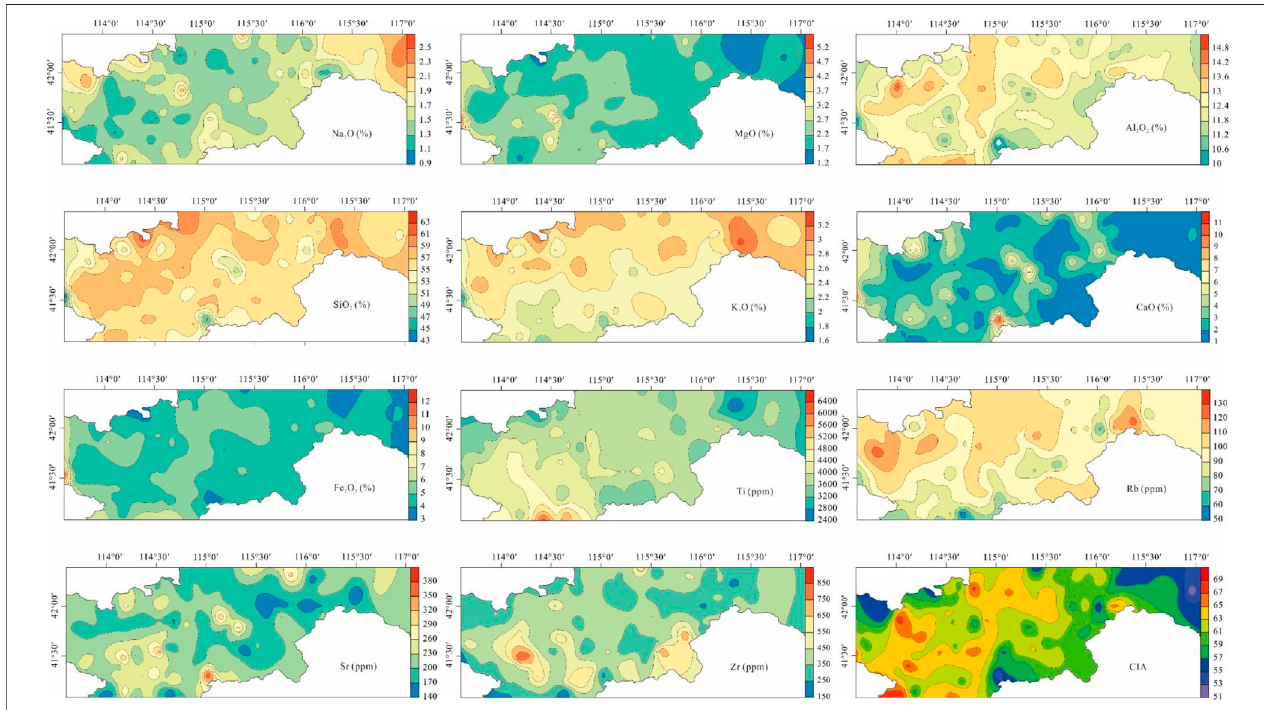
FIGURE 2 | Spatial distribution of elements in the surface sediments of the Bashang